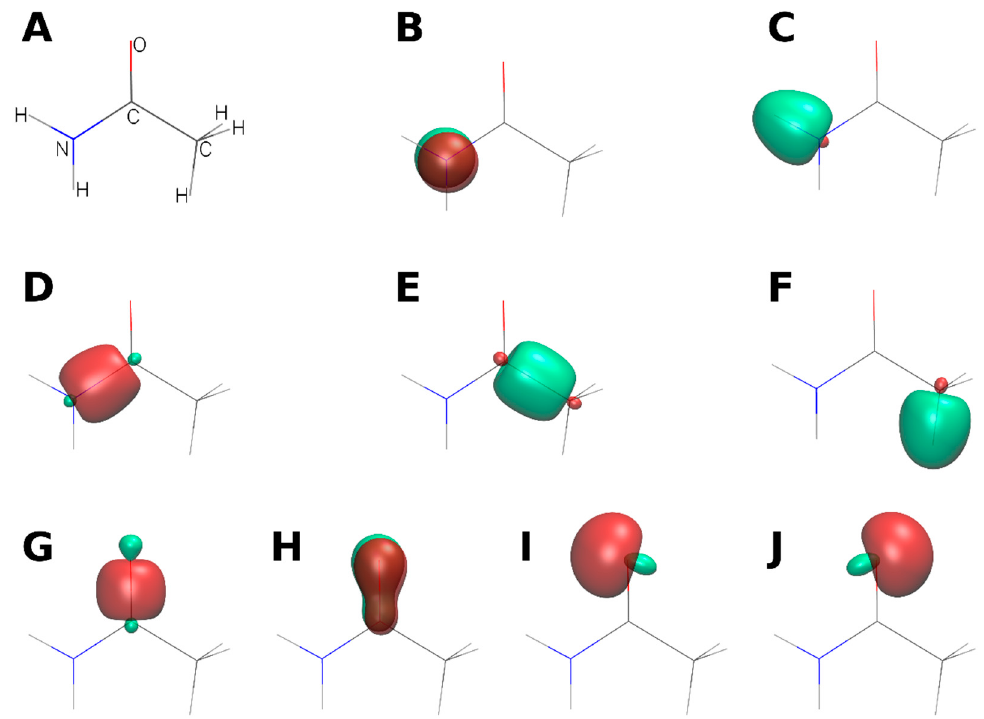
Figure 1. Examples of extremely localized molecular orbitals computed for acetamide (see panel ( A )) using a localization scheme corresponding to the Lewis diagram of the molecule: ( B ) ELMO describing the lone pair of the nitrogen atom, ( C ) ELMO associated with one of the two N-H bonds, ( D ) ELMO corresponding to the N-C bond, ( E ) ELMO describing the C-C bond, ( F ) ELMO associated with one of the three C-H bonds, ( G , H ) ELMOs corresponding to the C=O double bond ( σ and π orbitals, respectively), ( I , J ) ELMOs for the lone pairs of the oxygen atom. All the orbitals were computed with the cc-pVDZ basis set and were plotted considering a 0.15 a.u. isosurface.